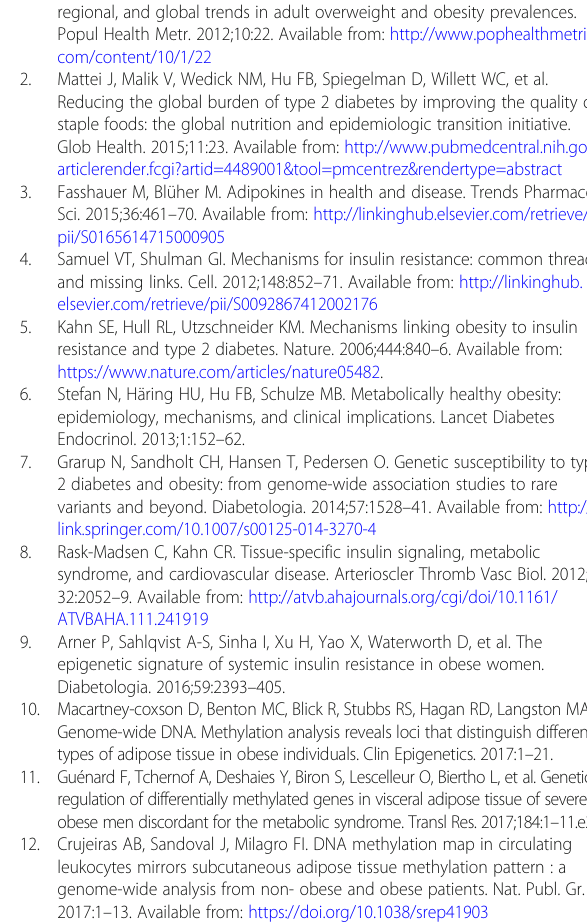
Additional file 1 Figure S1. Clustering of methylation data from tissue samples from individuals with obesity. Figure S2. Comparison of methylation averages among tissue types. Figure S3. Comparison of DMCs between different tissues. Figure S4. Differential gene expression. Table S1. List of DMCs in WB in the comparison between the DO and NDO groups. Table S2. List of DMCs in SAT in the comparison between the DO and NDO groups. Table S3. List of DMCs in VAT in the comparison between the DO and NDO groups. Table S4. List of DMCs in LT in the comparison between the DO and NDO groups. Table S5. Gene ontology enrichment analysis using the genes with DMCs in SAT. Table S6. Gene ontology enrichment analysis using the genes with DMCs in VAT. Table S7. Gene ontology enrichment analysis using the genes with DMCs in LT. Table S8. Differential gene expression in WB in the comparison between DO and NDO groups. Table S9. Differential gene expression in SAT in the comparison between DO and NDO groups. Table S10. Differential gene expression in VAT in the comparison between DO and NDO groups. Table S11. Differential gene expression in LT in the comparison between DO and NDO groups. Table S12. List of genes with correlation between alteration of DNA methylation and differential gene expression in WB. Table S13. List of genes with correlation between alteration of DNA methylation and differential gene expression in SAT. Table S14. List of genes with correlation between alteration of DNA methylation and differential gene expression in VAT. Table S15. List of genes with correlation between alteration of DNA methylation and differential gene expression in LT. Table S16. Gene ontology enrichment analysis using the genes with correlation between alteration of DNA methylation and differential gene expression. (PDF 3440 kb) Abbreviations CpGs: CpG sites; DMCs: Differentially methylated CpG sites; DO: Diabetic individuals with obesity; GO: Gene Ontology; LT: Liver tissue; NDO: non-diabetic individuals with obesity; SAT: Subcutaneous adipose tissue; T2D: Type 2 diabetes; VAT: Visceral adipose tissue; WB: Whole